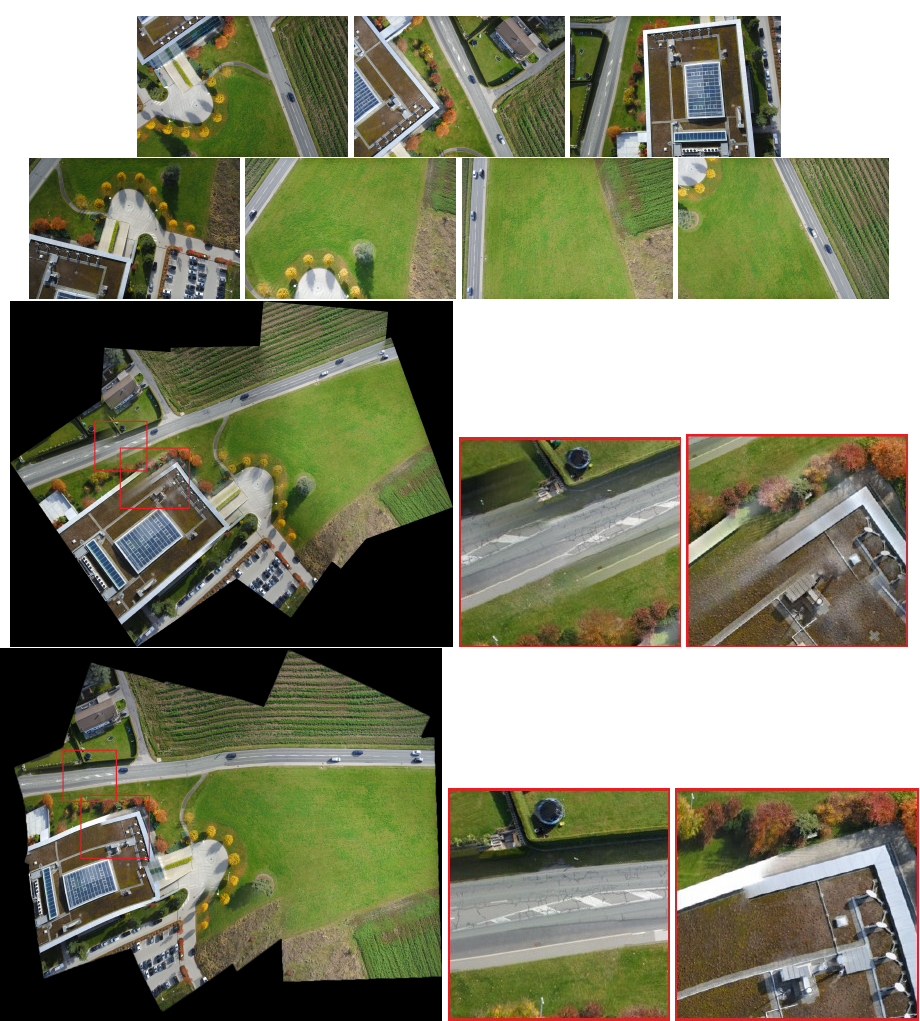
Figure 11. Experimental results on panoramic stitching. The first and second rows are the images to be stitched together. The third and fourth rows are the results of Autostitch and our method. Red boxes highlight the ghostly